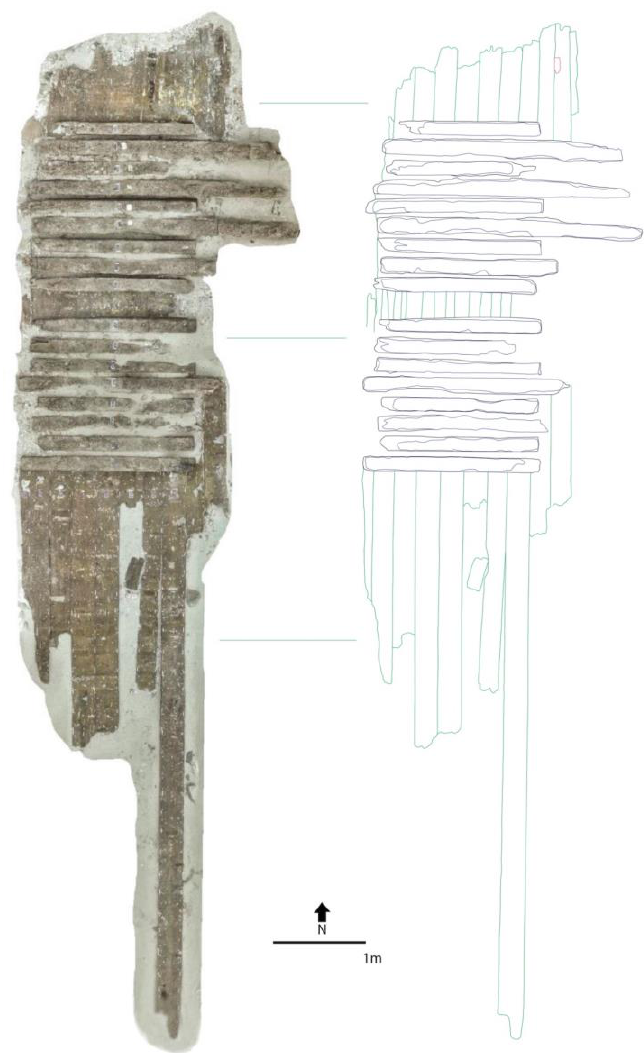
Figure 5. On the left, orthophoto of the shipwreck of the 2018 campaign from the photogrammetry model carried out with RealityCapture (photogrammetry: Bruno Derenne/Georges Verly). On the right, CAD orthomap produced from the orthophoto at scale (CAD: Verly